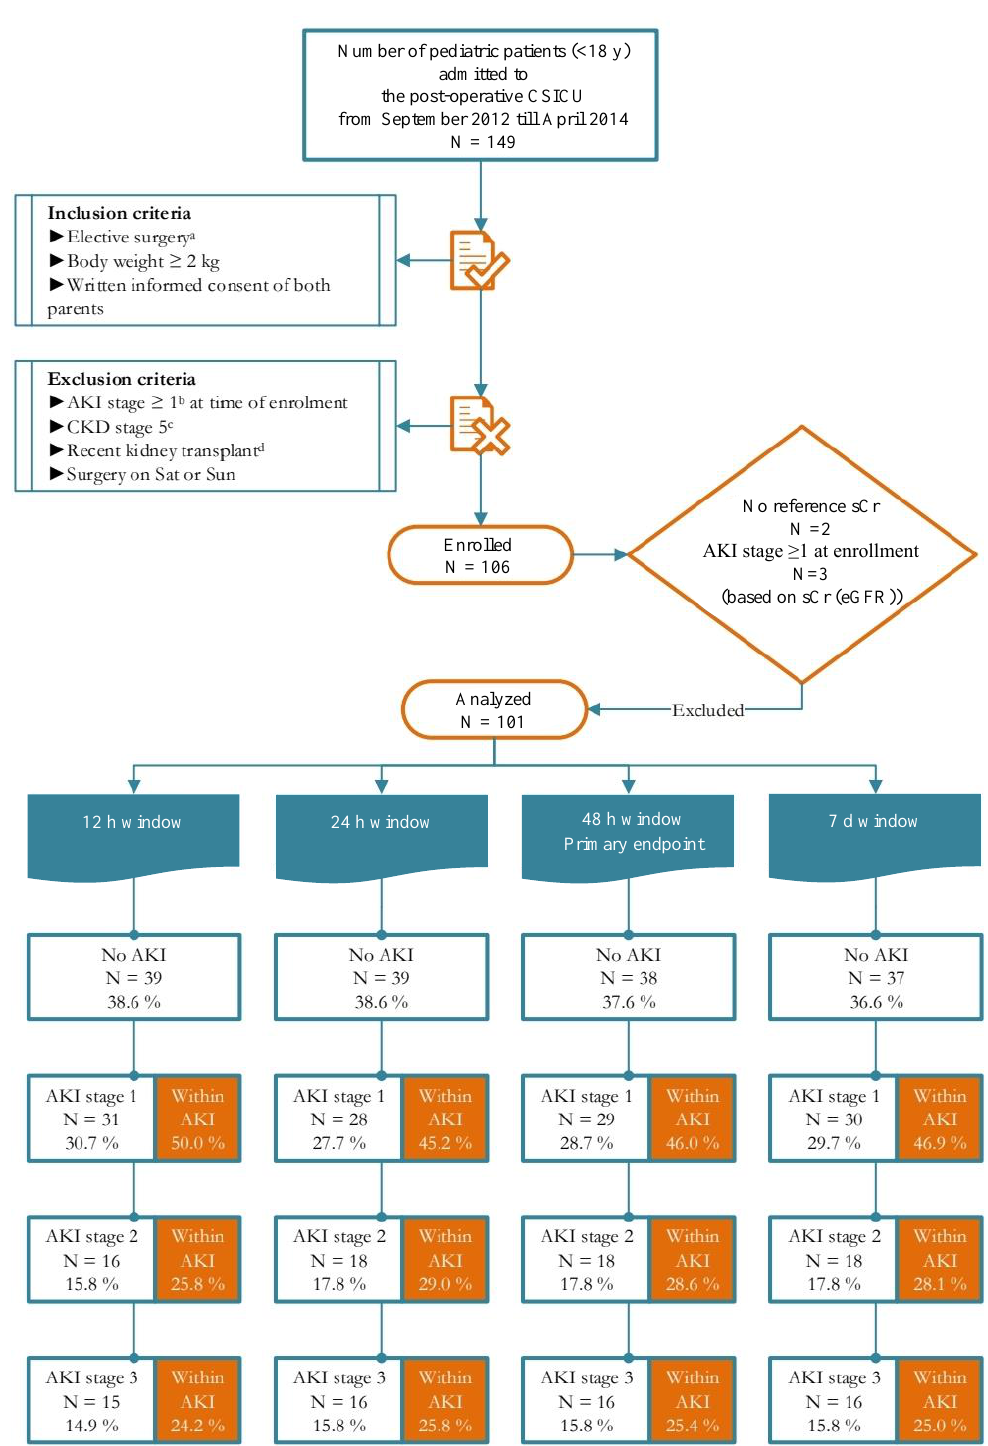
Figure 1. Study flow diagram. a Planned ≥ 4 h in advance; b KDIGO definitions for the diagnosis and staging of AKI, which are based on sCr and UO [3]; c KDOQI definitions for the diagnosis and staging of CKD [17]; d ≤ 3 mo before; AKI: acute kidney injury; CKD: chronic kidney disease; CSICU: cardiac surgery intensive care unit; h: hour; eGFR: estimated glomerular filtration rate; KDIGO: Kidney Disease: Improving Global Outcomes; KDOQI: Kidney Disease Outcomes Quality Initiative; mo: month; No.: number; Sat: Saturday; sCr: serum creatinine; Sun: Sunday; UO: urine output; y: